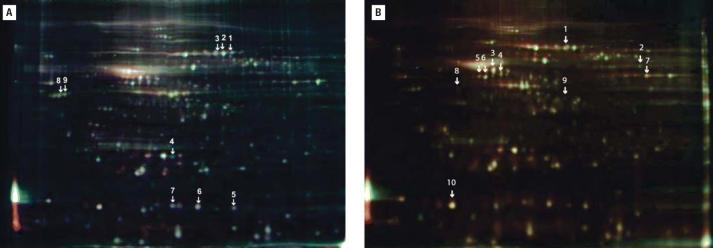
2D-DIGE image of fluorescently labeled proteins from striatum (A) and hippocampus (B) of PD11 mice. Proteins were extracted from the striatum (A) and hippocampus (B) of mice 24 hr after they received a single oral dose of PBDE-99 (treated) or vehicle (control) on PD10. Proteins were labeled with Cy3 (control), Cy5 (treated), and Cy2 (mixture of control and treated as internal reference; see “Material and Methods”) and separated on pH 4–7 IPG strips in the first dimension. This procedure was followed by separation on 12.5% SDS–polyacrylamide gels in the second dimension, and the gels were scanned with a Typhoon 9400 fluorescent scanner. The arrows point to the 9 (A) and 10 (B) spots found to be regulated and identified spots, respectively. The numbers correspond to the numbers in Table 1.